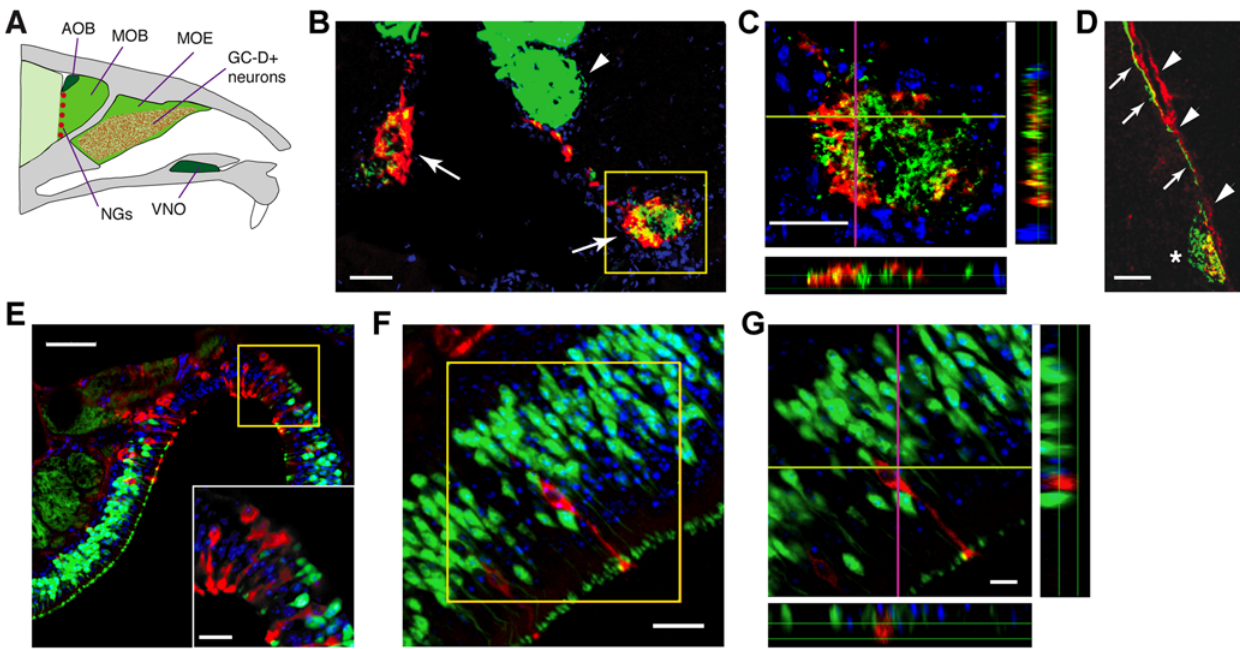
Figure 1. Nonoverlapping expression of PDE2 and OMP in necklace glomeruli and MOE. (A) The mouse main and accessory olfactory systems. The main system (bright green) includes the main olfactory epithelium (MOE) and main olfactory bulb (MOB). GC-D + neurons (red stippling) are dispersed amongst canonical OSNs in restricted regions of the MOE. Necklace glomeruli (NGs; red circles) are in the caudal MOB. The accessory system (dark green) is comprised of the vomeronasal organ (VNO) and accessory olfactory bulb (AOB). Adapted from [3], with permission from Elsevier. (B) NGs in paired MOBs of an OMP-tauEGFP + / 2 ::Gucy2d-Mapt-lacZ + / 2 mouse. EGFP, green; PDE2, red. Arrowhead: canonical MOB glomerulus; arrows: necklace glomeruli; box, shown in (C). (C) Orthogonal views (right, bottom; vertical, horizontal lines are planes of optical section) of a single NG confocal z-stack showing little overlap of EGFP-positive (green) and PDE2-positive (red) axons. (D) MOB section from Gucy2d-Mapt-lacZ + / 2 mouse, immunostained for OMP (green), b -gal (red). Arrows: OMP-positive axons; arrowheads: b -gal-positive axons. (E) MOE dorsal recess of OMP-tau-EGFP + / 2 mouse shows clusters of PDE2-positive/EGFP-negative (red) and PDE2-negative/GFP-positive (green) neurons. Yellow box: area magnified 2-fold, inset (F) Single PDE2-positive OSN (red) in the MOE of an OMP-tau-EGFP + / 2 mouse. EGFP, green; box, shown in (G). (G) Orthogonal views in MOE of single PDE-positive/EGFP-negative (red) neuron and multiple PDE2-negative/EGFP-positive (green) neurons. Confocal z-stack (B,C,E–G); single optical section (D). Scale bars: 50 m m (B–D); 10 m m (E–G). Blue,